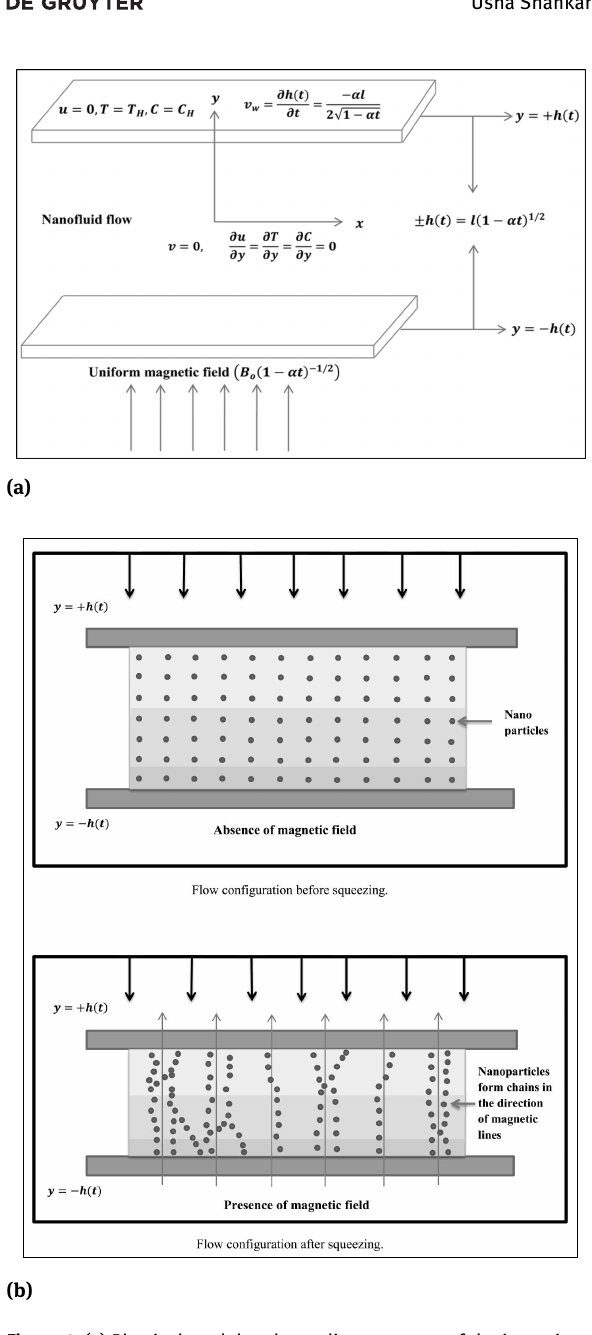
Figure 1: (a) Physical model and coordinate system of the investi- gated problem. (b) Influence of magnetic field on nanofluid flow behaviour